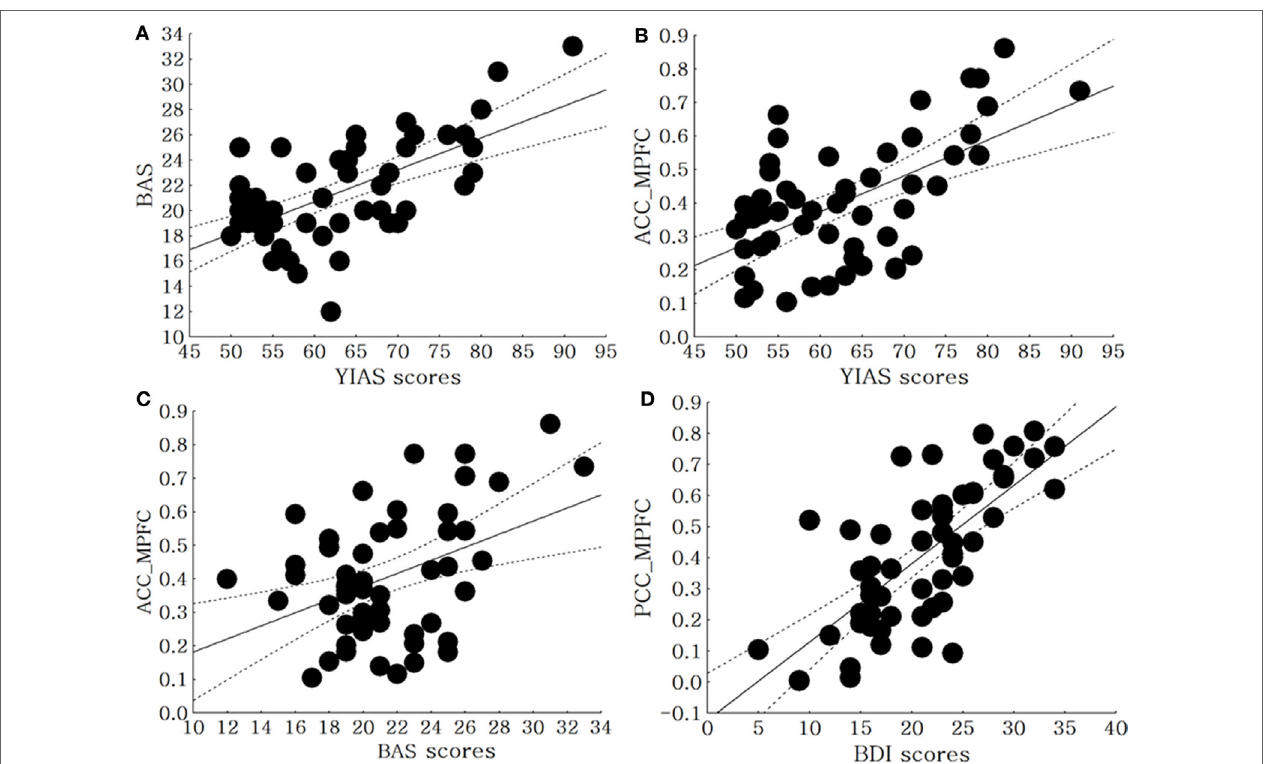
FigUre 2 | Correlation between clinical scales and brain connectivity in all patients with major depressive disorder (MDD) and Internet gaming disorder (IGD). (a) Correlation between the BAS scores and the Young Internet Addiction Scale (YIAS) scores in all patients with MDD with IGD ( r = 0.63, p < 0.01), (B) correlation between the YIAS scores and FC between anterior cingulate cortex (ACC) to middle prefrontal cortex (MPFC) in all Patients with MDD with IGD ( r = 0.58, p < 0.01), (c) correlation between the BAS scores and FC between ACC to MPFC in all patients with MDD with IGD ( r = 0.42, p < 0.01), (D) correlation between the Beck Depressive Inventory (BDI) scores and FC between PCC to MPFC in all patients with MDD with IGD ( r = 0.51, p <